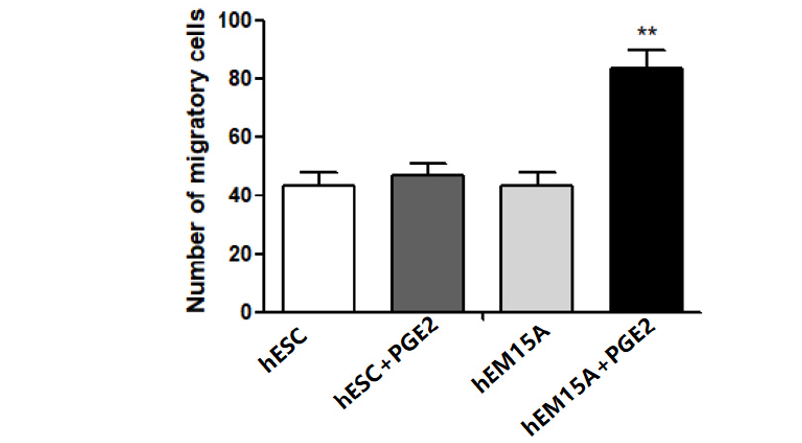
Figure 3. After added 75 ng/mL PGE2 for 24 h in hEM15A and hESC, Transwell migration assay was to evaluate the effect of PGE2 on the migration of hESC and hEM15A.The data are expressed as means ± SEM. ** p < 0.05 by one-way ANOVA.